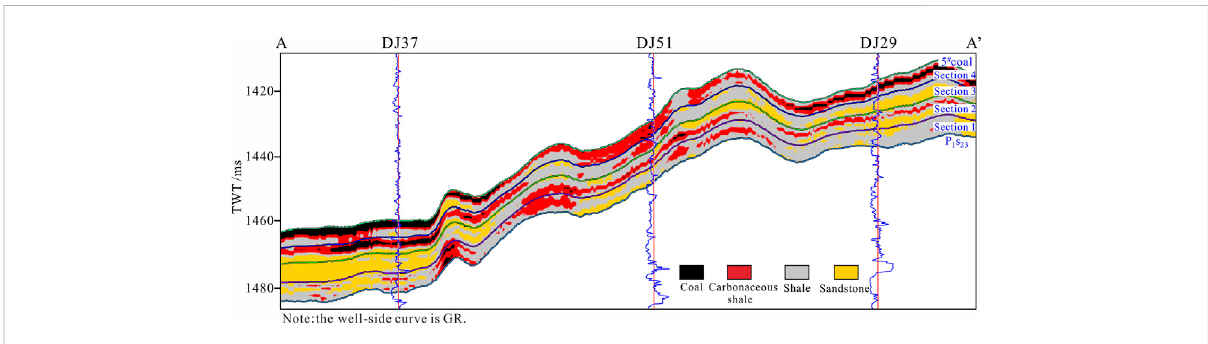
FIGURE 8 Lithologic inversion pro fi le of the Shan-2 Lower Sub-member in the eastern Ordos Basin (see A – A ′ in Figure 9 for pro fi le